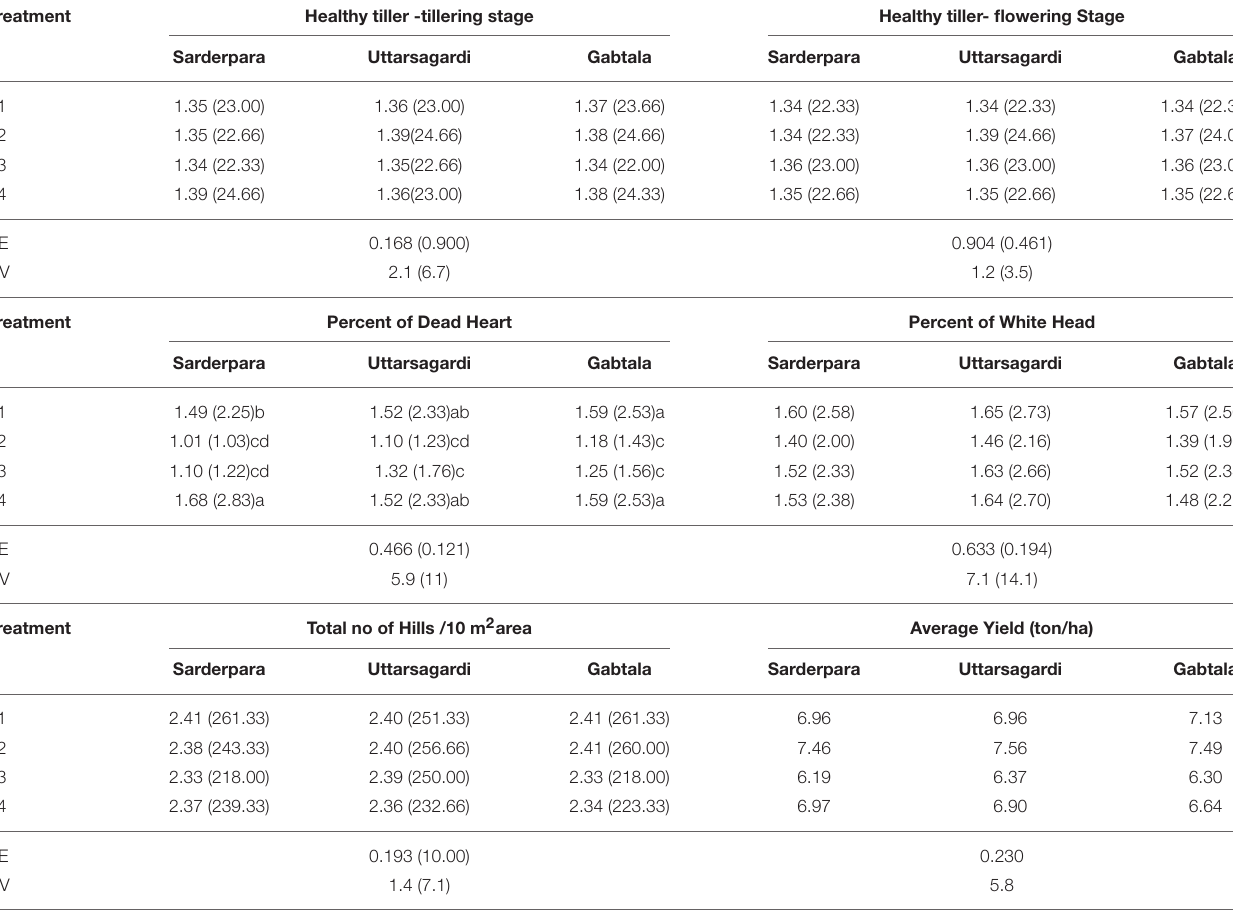
TABLE 4 | Interation effect of location and treatment on tillers, hills, dead heart, white head and yield of rice crops in 2011-12. Treatment